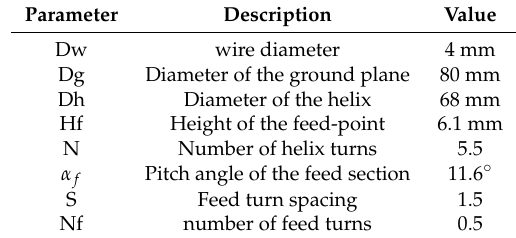
Table 4. Design parameters of backfire helical antenna.